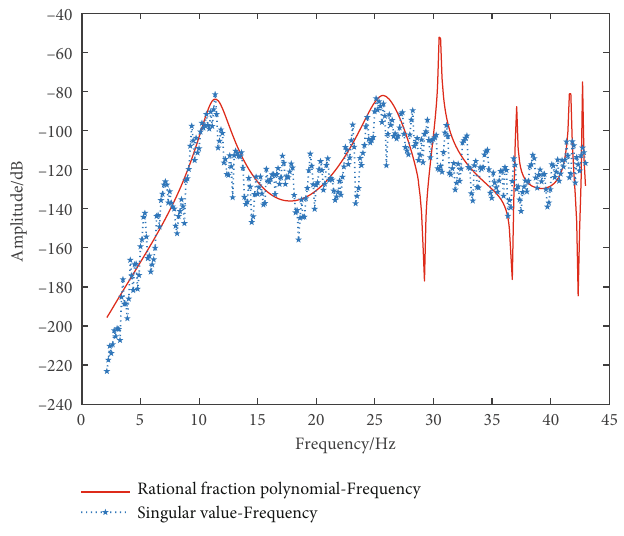
Figure 18: System parameters identi fi cation result.